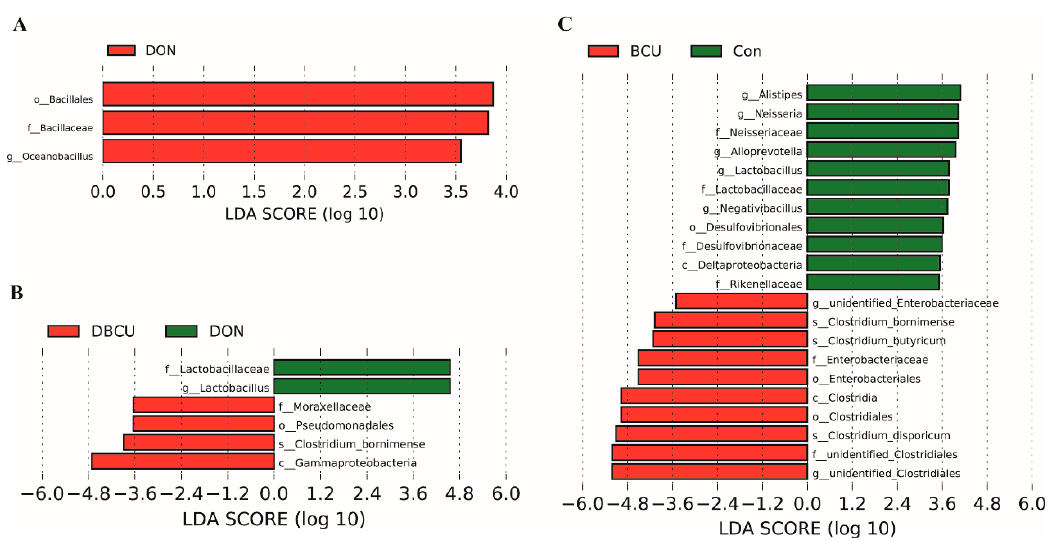
Figure 3. Linear discriminant analysis effect size (LEfSe) analysis of the piglet intestinal microbiota data. ( A ) DON and Con group, ( B ) DON and DBCU group, ( C ) BCU and Con group. LEfSe identified significantly different bacterial taxa (LDA Score>3.5). Basal diet (Con); 4 mg DON/kg diet (DON); 5 g BCU/kg diet (BCU); 5 g BCU/kg with 4 mg DON/kg diet (DBCU).